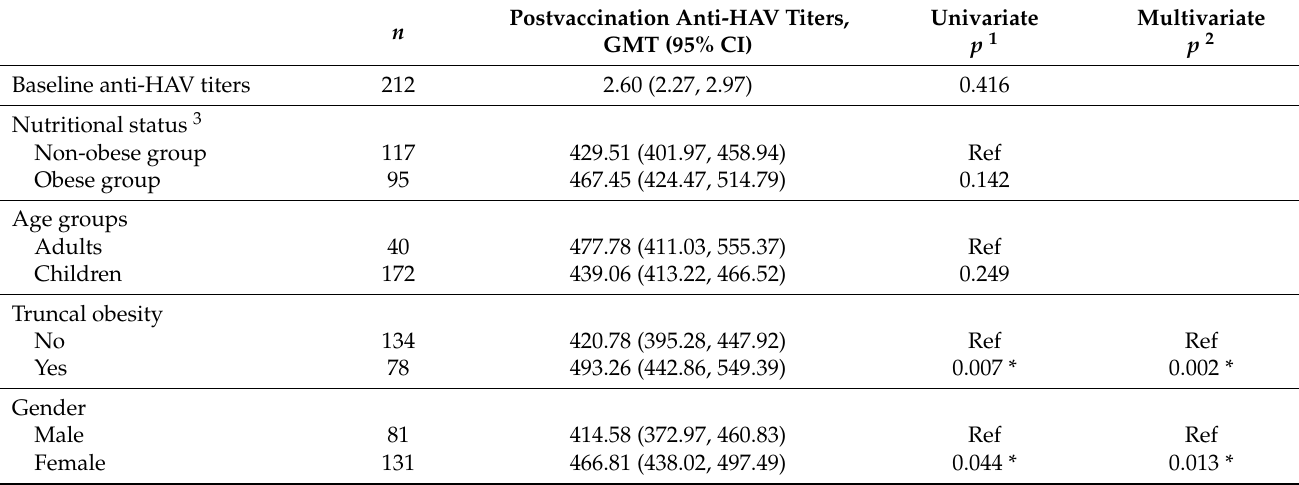
Table 2. Association between baseline characteristics and postvaccination anti-hepatitis A virus (HAV) titers. Postvaccination Anti-HAV Titers, n GMT (95%